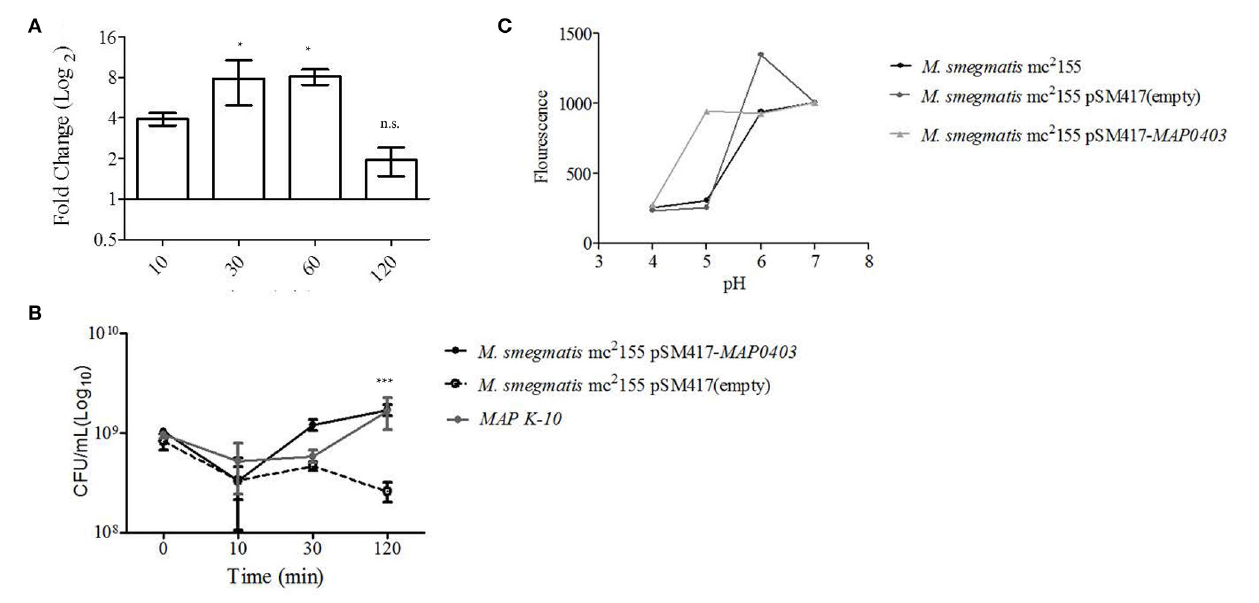
FIGURE 3 | MAP0403 aids in bacterial survivability during in vitro acid exposure. (A) MAP K-10 was exposed to acidified (pH = 5.0) MB7H9 for 10, 30, and 120 min, recovered, and analyzed for MAP0403 expression by qT-RT-PCR. MAP0403 was up-regulated by 4-fold within 10 min of acid exposure and reached peak expression by 30 and 60 min. (B) MAP K-10, M. smegmatis mc 2 155 parent, MAP0403 expression strain (pSM417- MAP0403 ), and vector control [pSM417 (empty)] were exposed to the same acid conditions as (A) and underwent direct plating to determine viability counts. MAP K-10 and M. smegmatis mc 2 155 expressing MAP0403 cells had higher rates of recovery compared to M. smegmatis mc 2 155 parent and vector control strains. (C) Intra-bacterial pH measurement in M. smegmatis mc 2 155 parent and transformants. Intra-bacterial pH was measured by a fluorescent marker, 5(6)-carboxyfluroescein N-hydroxysuccinimide, in M. smegmatis mc 2 155, MAP0403 expression strain (pSM417- MAP0403 ), and vector control [pSM417 (empty)] exposed to various pHs ranging from 4 to 7. Compared to controls, M. smegmatis pSM417- MAP0403 maintained its intra-bacterial pH in acidified medium (pH = 5). * P < 0.05, n.s. not significant.